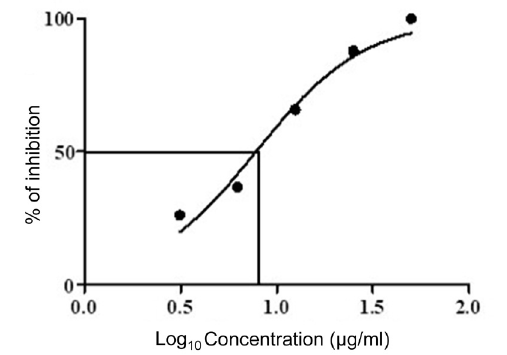
Fig. 8. Dose response curves (GraphPad Prism) of crude extract of Streptomyces cavourensis SKCMM1 against cancer cell